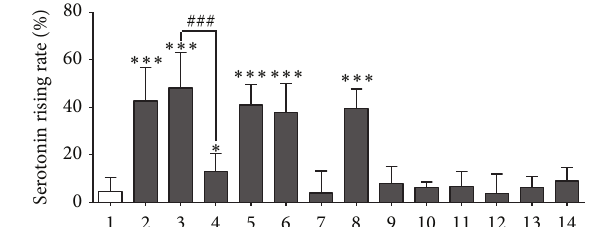
Figure 5: Increasing rate of 5-HT in guinea pig plasma; (1) saline; (2) egg albumin; (3) Reduning injection; (4) filtered Reduning injection; (5) Tween-80; (6) chlorogenic acid; (7) neochlorogenic acid; (8) cyclohexanecarboxylic acid; (9) gardenoside; (10) caffeic acid; (11) isochlorogenic acid A; (12) isochlorogenic acid B; (13) isochlorogenic acid C; (14) secoxyloganin. Values are expressed as mean ± SD; 𝑛 = 10 in each group. ∗ 𝑃 < 0.05 , and ∗∗∗ 𝑃 < 0.001 versus saline. ### 𝑃 < 0.001 versus filtered Reduning